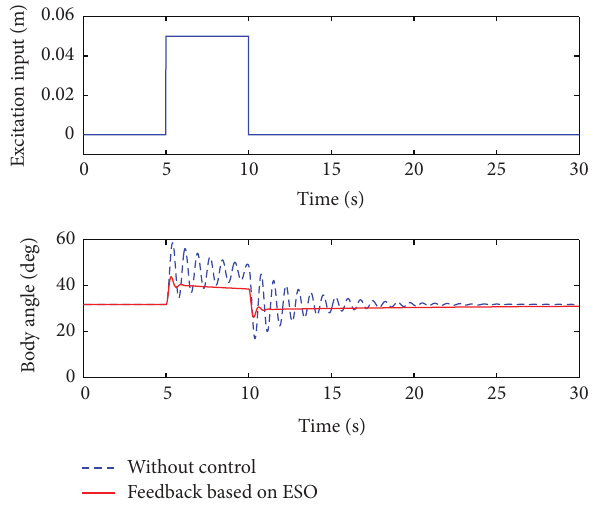
Figure 4: Step excitement input simulation results.